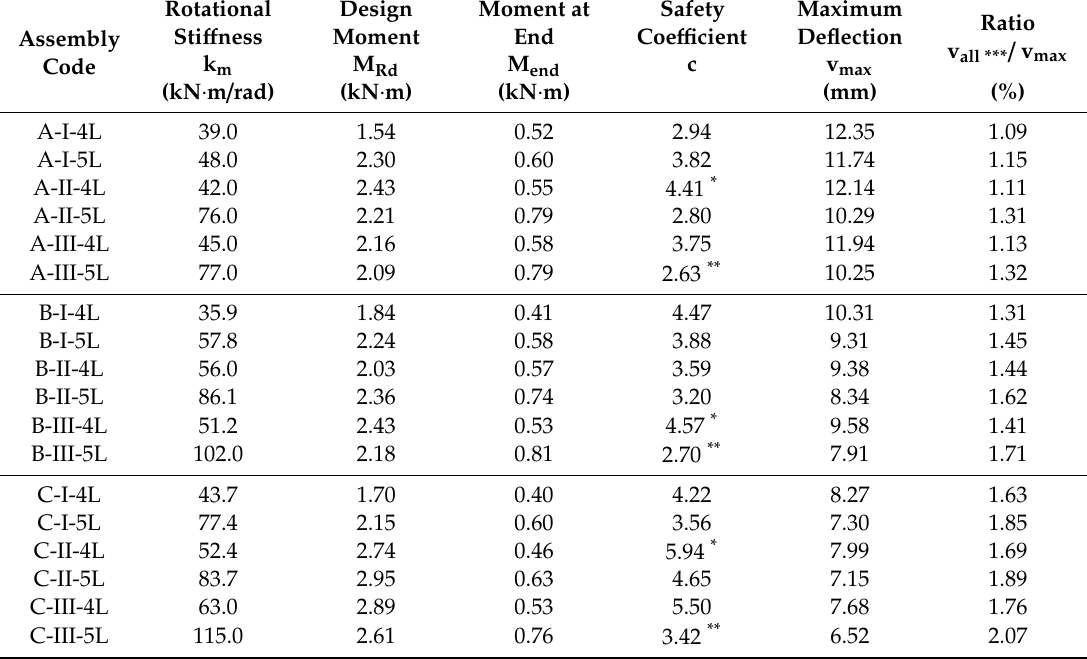
Table 7. Results for the safety coe ffi cient c of the connection for the maximum deflection in case of the assemblies tested for the case of the real loading in the pallet racking storage system.